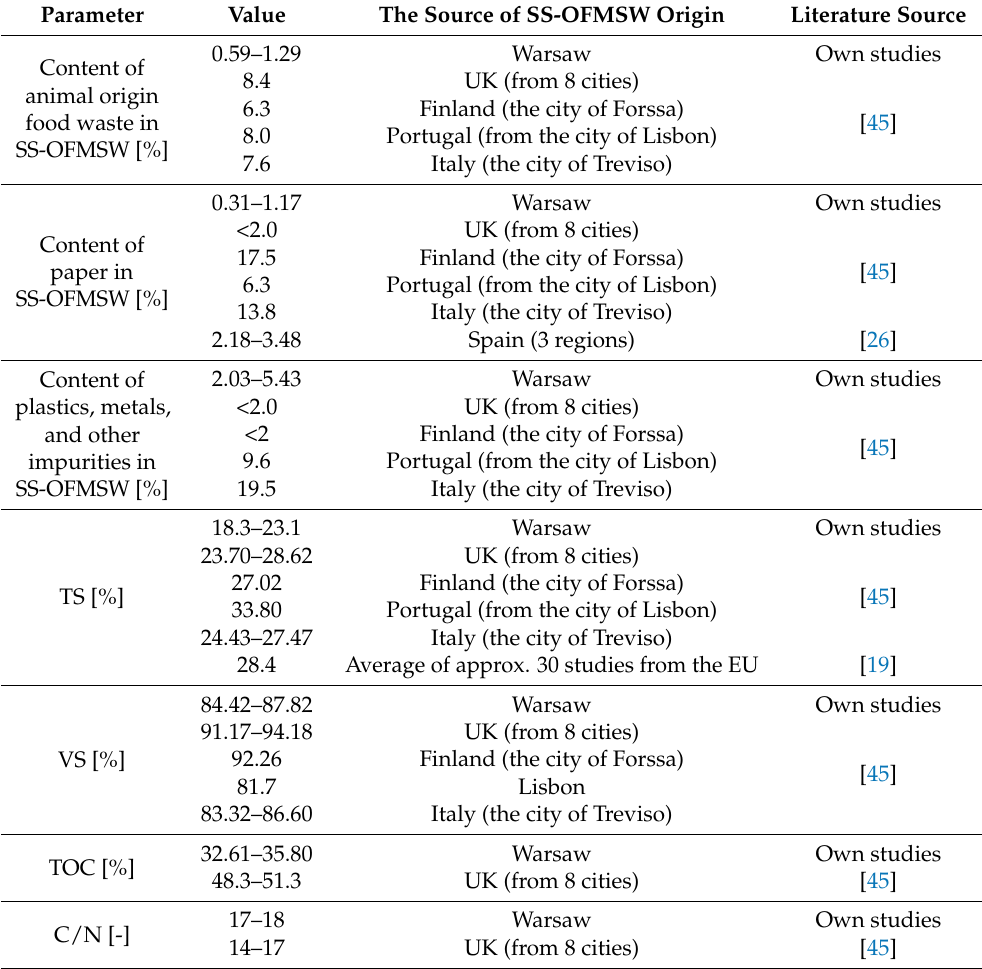
Table 6. Selected SS-OFMSW properties tested for Warsaw in comparison with chosen European regions.